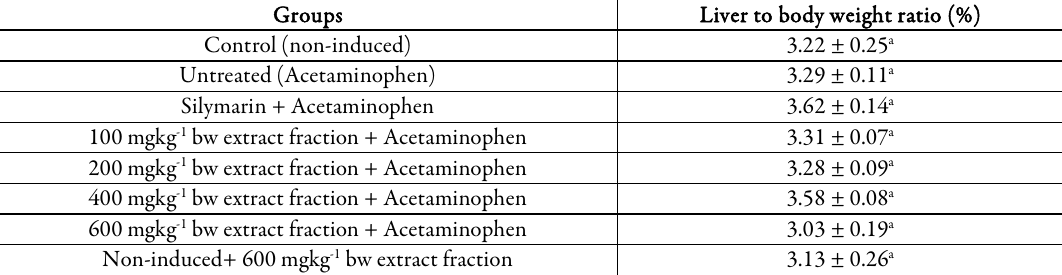
Table 3. Specific activities of alanine aminotransferase (ALT), aspartate aminotransferase (AST), alkaline phosphate (ALP) and γ-glutamyltransferase (GGT) (nmolmin -1 mgprotein -1 ) in the serum of the rats